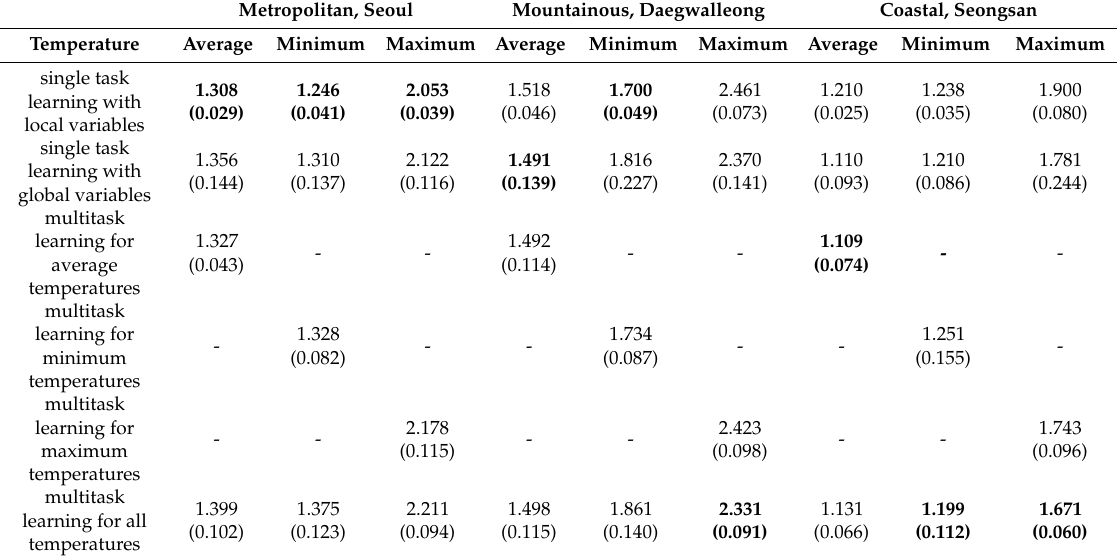
Table 21. Forecasting results of, represented using the MAE for global variables and multitask learning. Metropolitan,